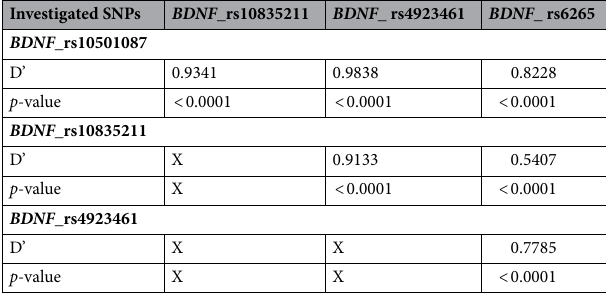
The BDNF rs10835211 polymorphism, obesity, glucose homeostasis parameters, and lipid profiles, dependently on dietary factors